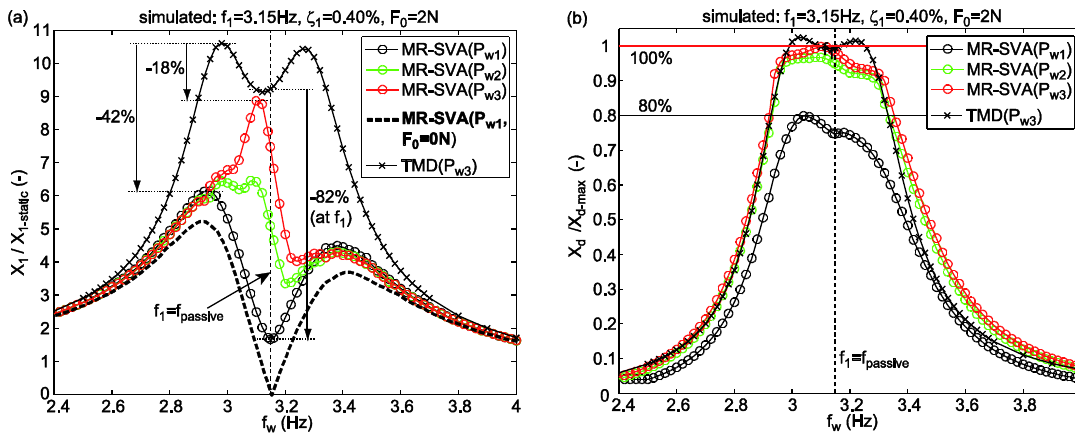
Figure 4. Simulated ( a ) vibration reduction and ( b ) relative motion amplitude for nominal primary structure.